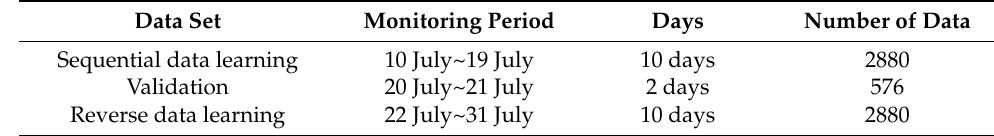
Figure 5. The train and test data set for developing the LSTM model. Table 1. Date information periods during the experimental period.